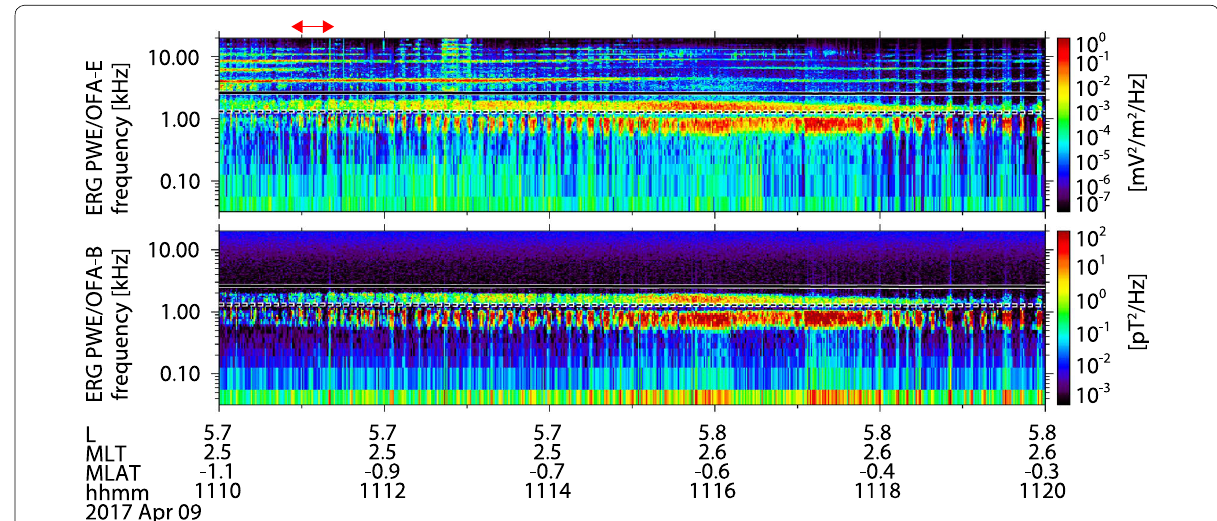
Fig. 17 An enlarged view of electric and magnetic field spectra as measured by the OFA-SPEC from 11:10 to 11:20 UT on April 09,